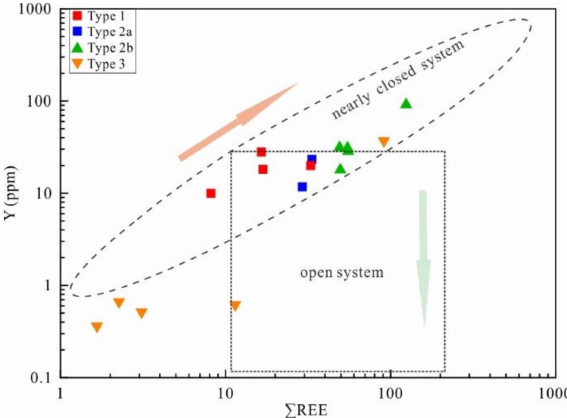
Figure 14. Scatter diagrams of yttrium (Y) versus the total REEs for garnets in the Laoshankou deposit (modified after [16]).